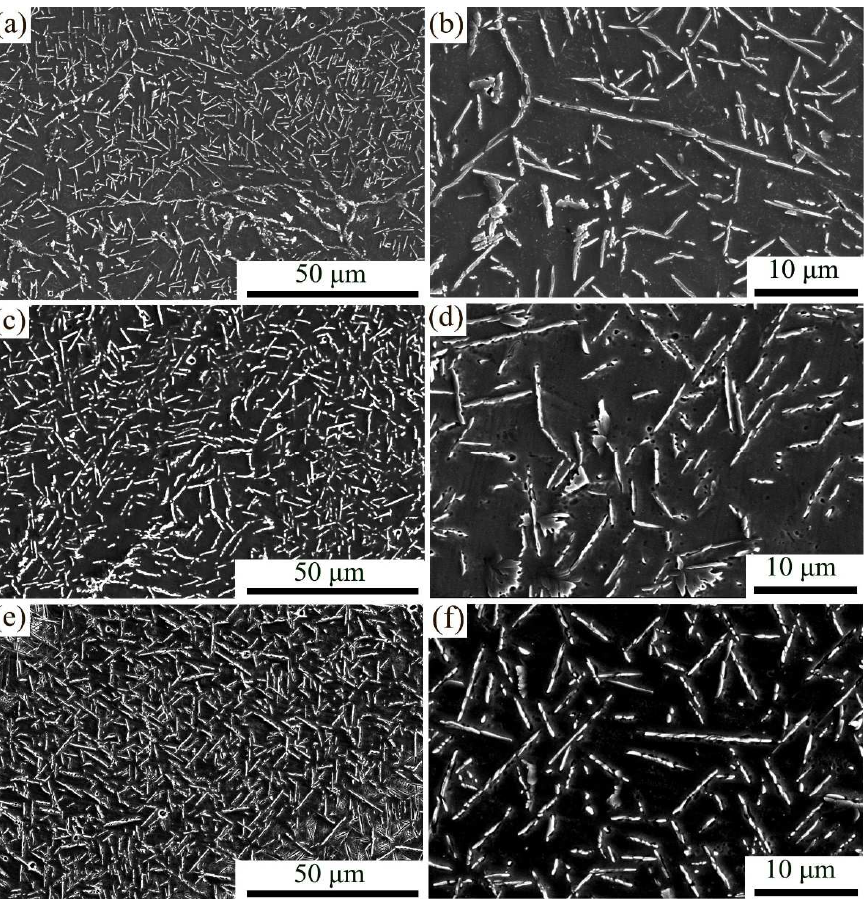
Figure 3. SEM images of the middle zones in the cross sections of coatings: ( a ), ( b ) Al 0.5 , ( c ), ( d ) Al 1.0 , ( e ), ( f ) Al 1.5 .